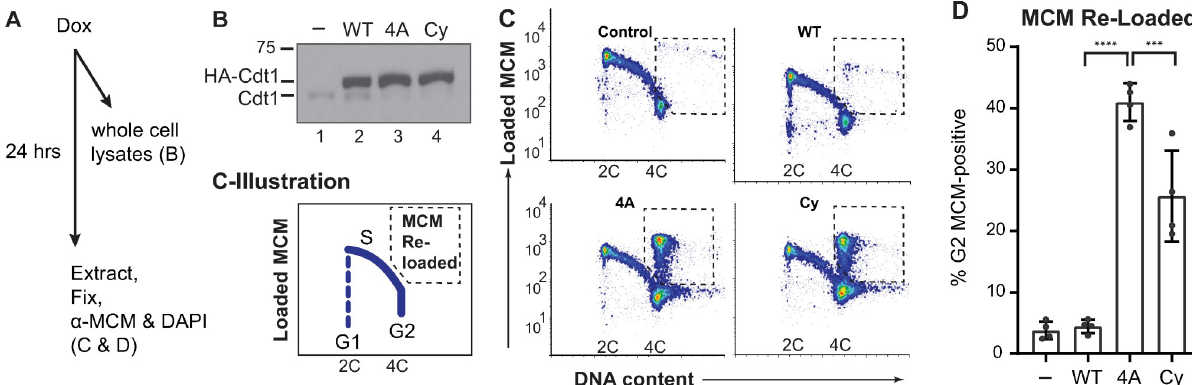
Fig 2. Cdt1 phosphorylation prevents MCM re-loading in G2 cells. A ) Workflow: Asynchronously proliferating U2OS cells with inducible Cdt1 were treated with 0.05 μ g/ml doxycycline then subjected to immunoblotting in B or analytical flow cytometry in C and D. B ) Immunoblot analysis of initial Cdt1 expression 6 hrs after dox induction. Lysates were probed with anti-Cdt1 to detect both endogenous and ectopic Cdt1. C ) Flow cytometry analysis of MCM loading 24 hrs after ectopic Cdt1 induction. Cells were detergent-extracted prior to fixation to remove unbound MCM, then stained for DNA content with DAPI (x-axes) and with anti-MCM2 as a marker of loaded MCM complexes (y-axes). One representative of multiple independent biological replicates is shown, and the illustration depicts typical positions of proliferating cells in G1, S, and G2 phase. The dashed boxes show the gates to quantify MCM re-loading in late S/G2 cells. D ) Quantification of four independent replicates as in C. The bars report means and standard deviations. Asterisks indicate statistical significance determined by one-way ANOVA ( ��� p = 0.0002, ���� p < 0.0001); Control vs WT was not significant as defined by p >